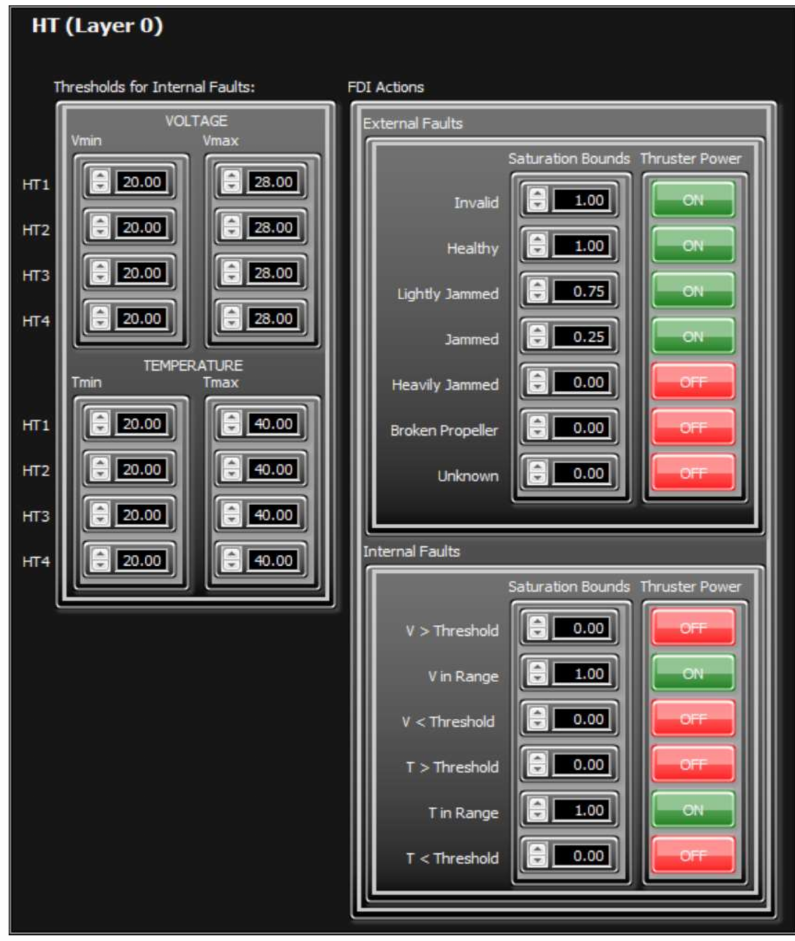
Figure 13. Fault Code Table for horizontal thrusters (Layer